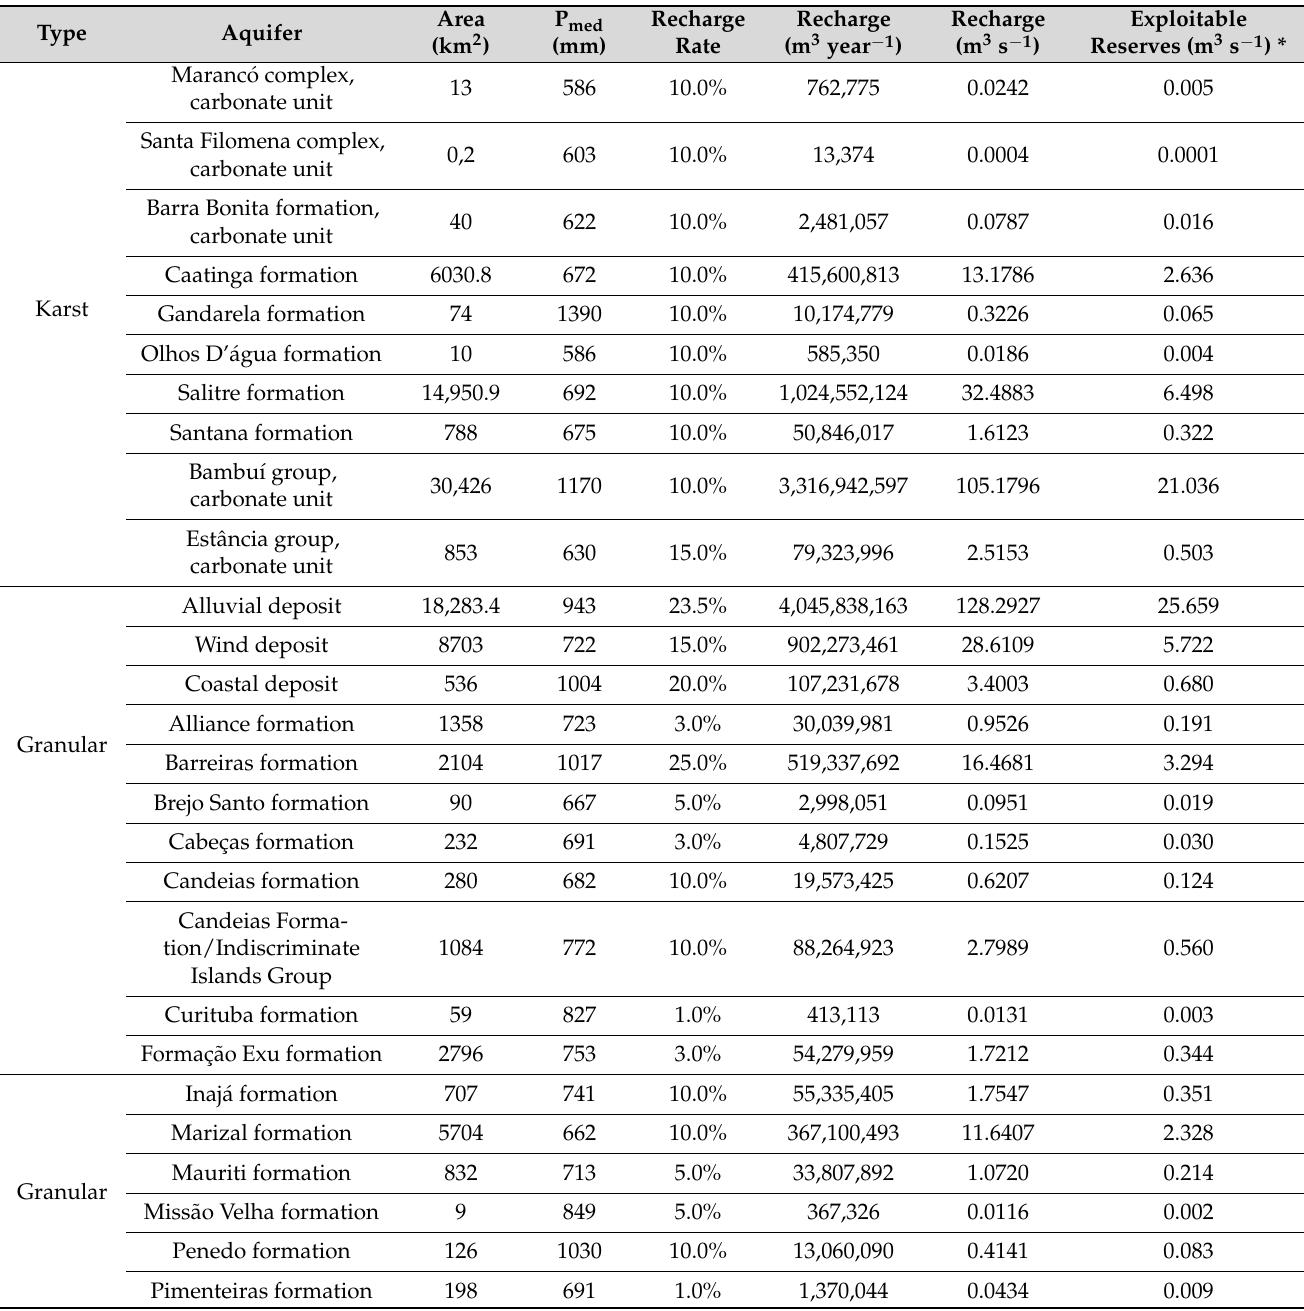
Table 12. Renewable groundwater availability (recharge) and reserve values, per aquifer system, resulting from the harmonization of the groundwater balance, obtained from the current state of hydrologic knowledge of aquifers and from the integrated analysis of surface and groundwater